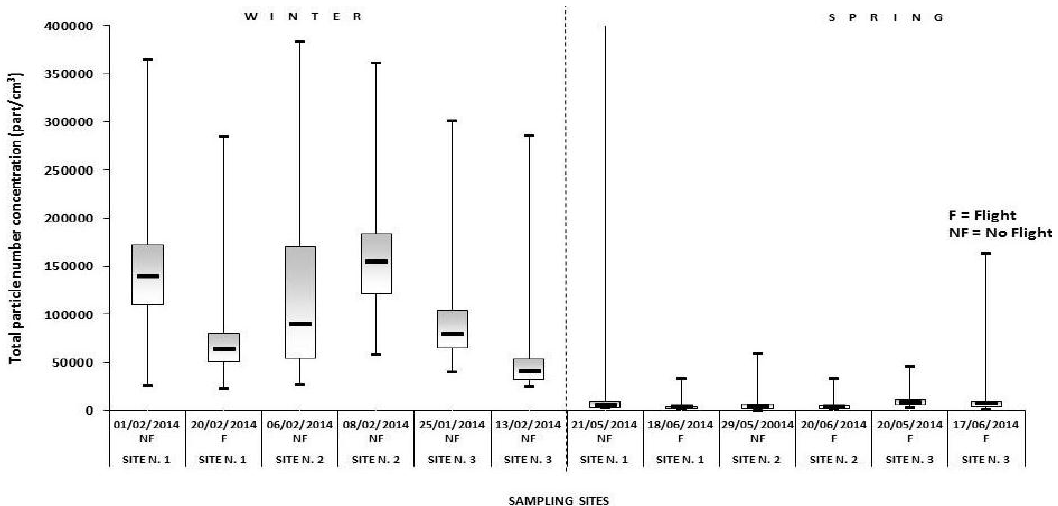
Figure 3. Range, interquartile range, and median ultrafine particle (UFP) number concentrations by site and season.